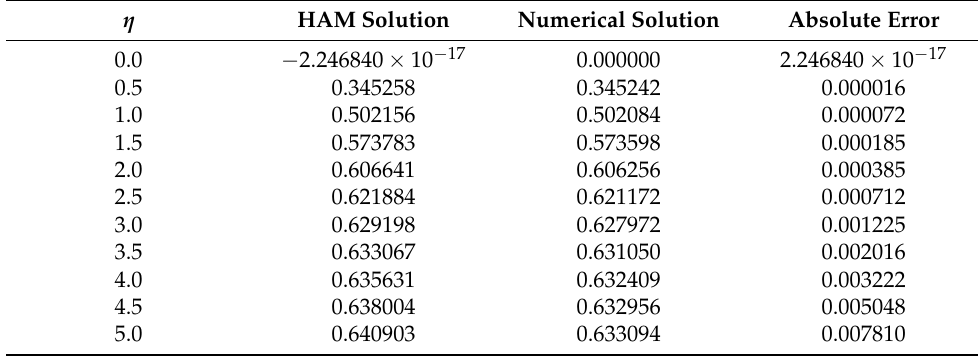
Table 3. Comparison of (Au-Cu)/Ethylene hybrid nanofluid temperature.